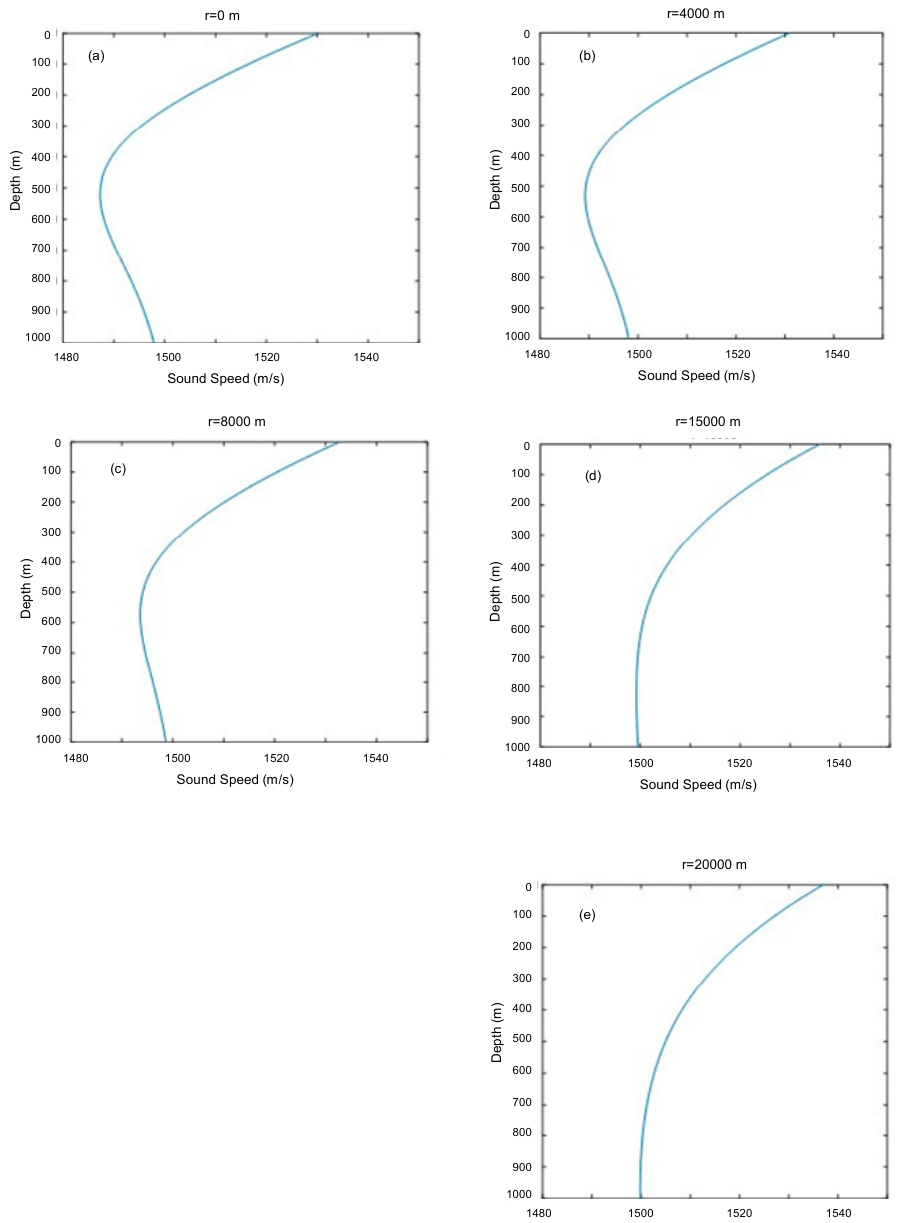
Figure 15. Variation in sound velocity gradient at different distances, ( a ) r = 0 m, ( b ) r = 4000 m, ( c ) r = 8000 m, ( d ) r = 15,000 m, ( e ) r = 20,000 m. ( b ) r = 4000 m, ( c ) r = 8000 m, ( d ) r = 15,000 m, ( e ) r = 20,000